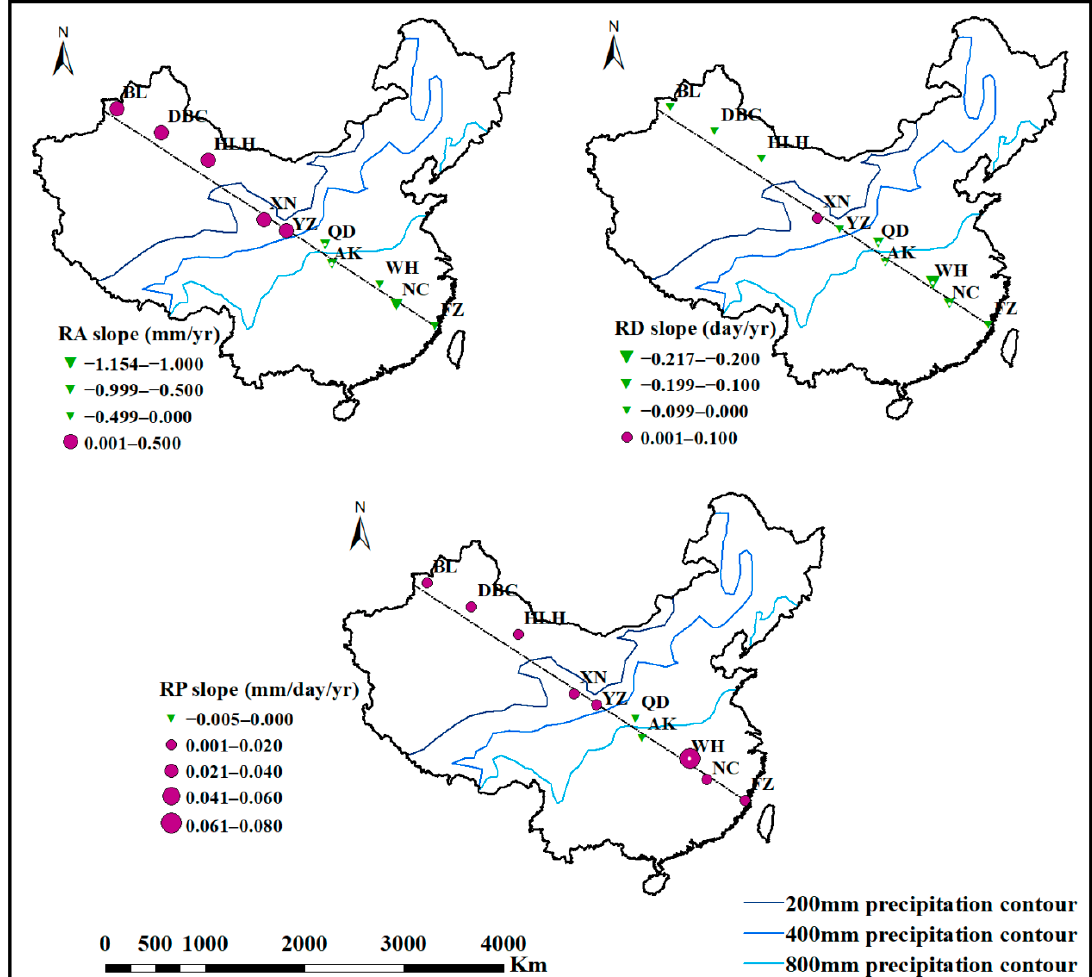
Figure 3. The Mann-Kendall trend test and Sen’s slope were used to reflect the variation trends for the spring precipitation indices, including rainfall amount (RA), rainfall days (RD), and daily precipitation on rainy days (RP). Note: white spots mean precipitation change trend reached the significance level of 95% confidence for the MK trend test.